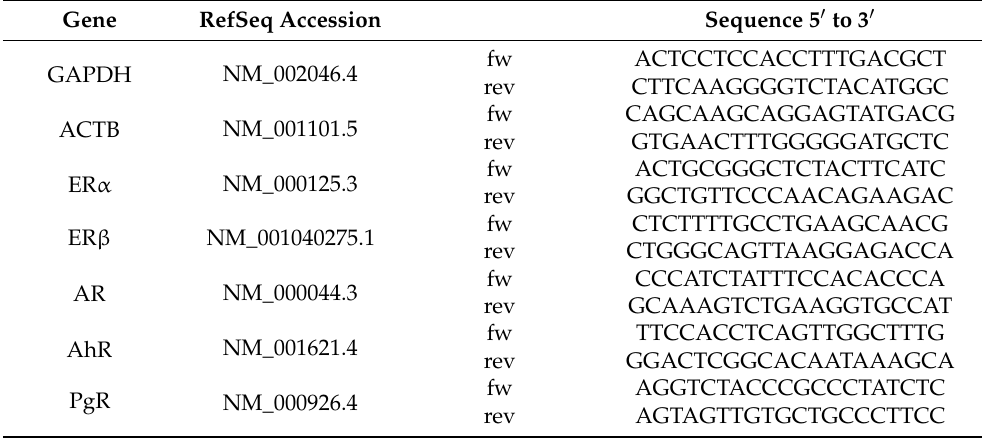
Table 1. Sequences of the specific primers used in real-time PCR analysis with accession numbers of the corresponding